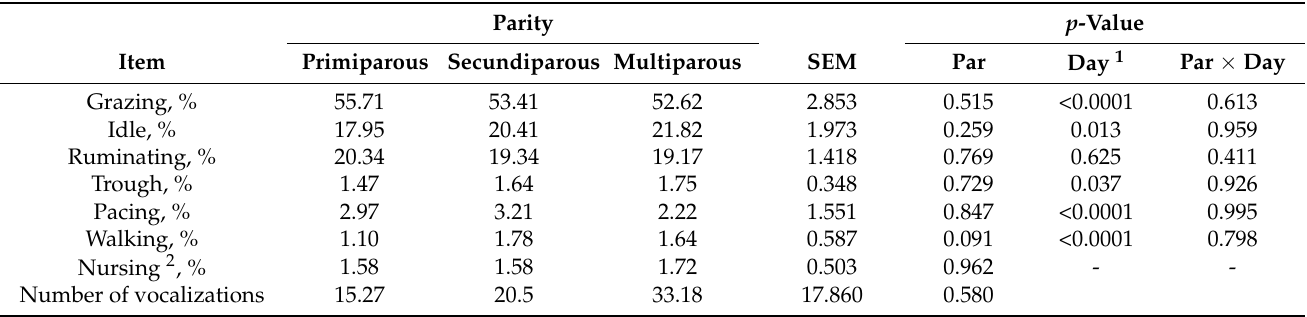
Table 3. Effect of parity on behavior observation in Nellore cows at abrupt weaning.